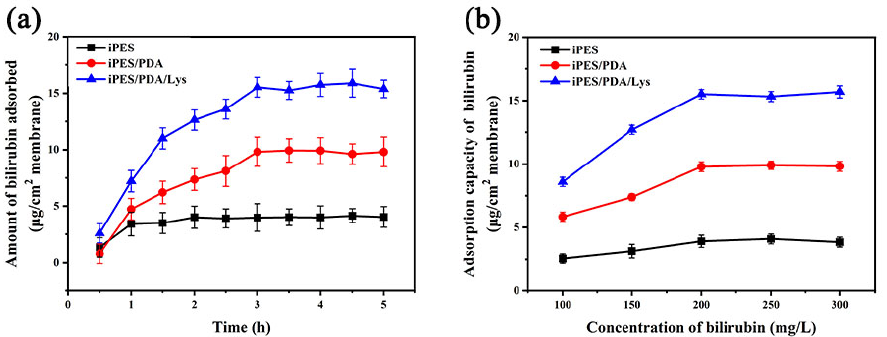
Figure 6. ( a ) Adsorption rates of bilirubin on the membranes. Initial bilirubin concentration: 200 mg/L. ( b ) The effect of bilirubin initial concentration on the adsorption capacities. Adsorption time: 3 h. The results are expressed as means ± SD (n =